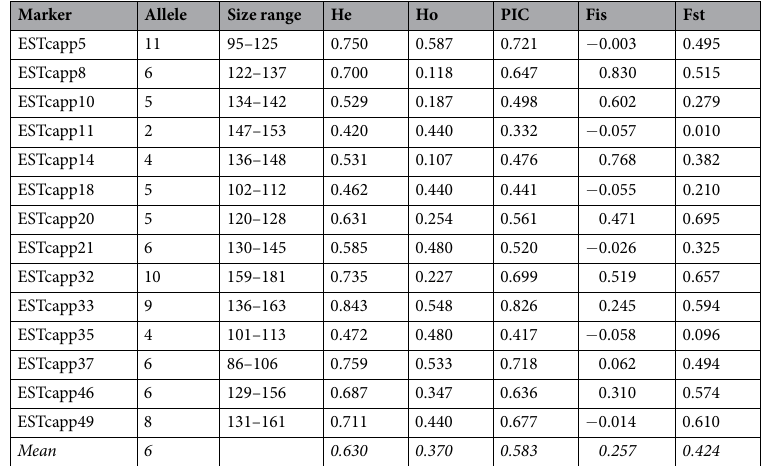
Table 5. Main genetic parameters from the 14 polymorphic EST-SSR loci of the population under investigation (sample size 75). He: Genetic diversity; Ho: Observed heterozygosity; PIC: Polymorphism Information Content; Fis: Inbreeding coefficient; Fst: Fixation index.